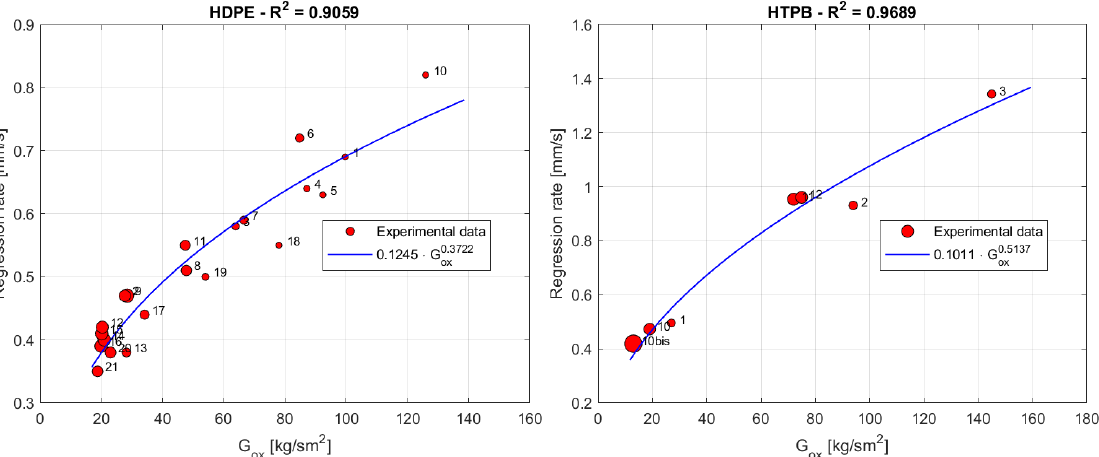
Figure 3. Regression rate as a function of oxidizer flux for the GOX-HDPE motor ( left , data in Table 1) and GOX-HTPB motor ( right , data in Table 2); different average port diameter corresponding to each point is represented by the size of the